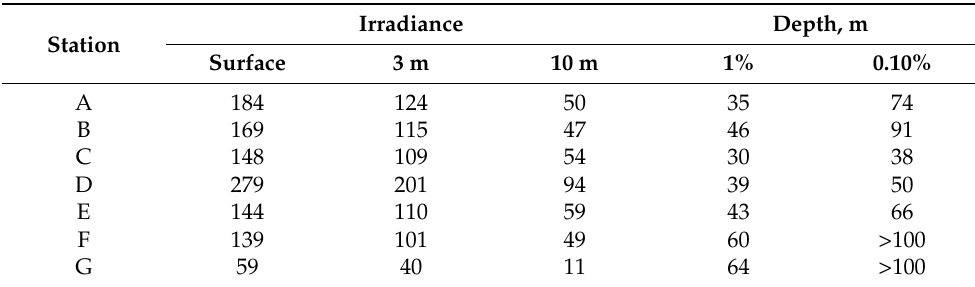
Table 3. Irradiance ( µ M photons · m − 2 · s − 1 ) at the water surface and at a depth of 3 and 10 m, as well as the depth where the irradiance is 1% and 0.1% of the surface irradiance.